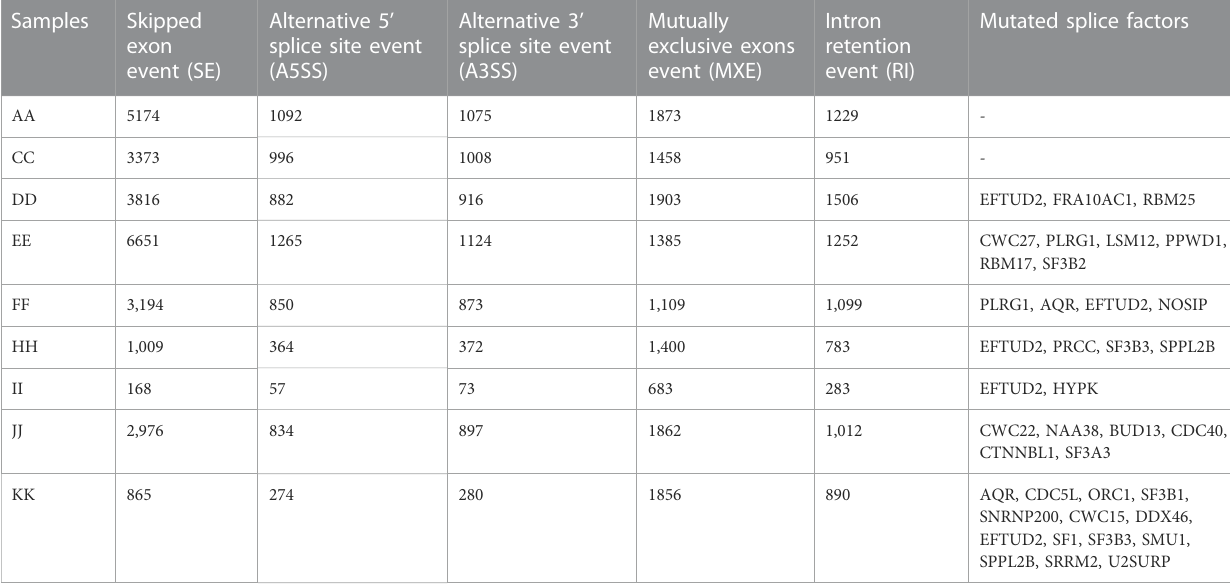
TABLE 8 Number of splicing events and mutated splice factors per